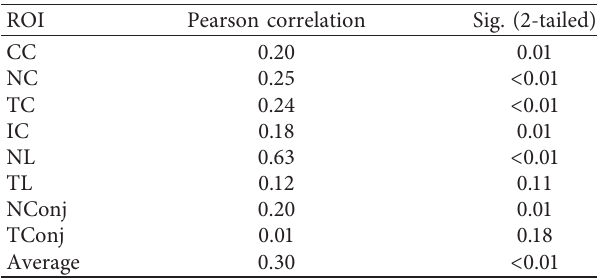
Average 0.30 < 0.01 DED, dry eye disease; ° C, degree Celsius; ROI, region of interest; AUC, area under the curve; CI, confidence interval; NC, nasal cornea; CC, central cornea; TC, temporal cornea; IC, inferior cornea; NL, nasal limbus; TL, temporal limbus; NConj, nasal conjunctiva; TConj, temporal